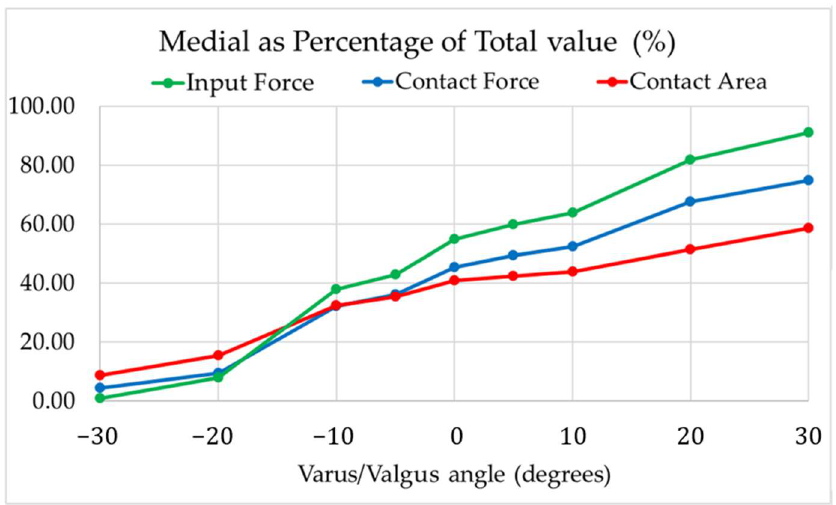
Figure 4. Input force, contact force and contact area relative to different varus/valgus angles for the cemented 50 mm stem.